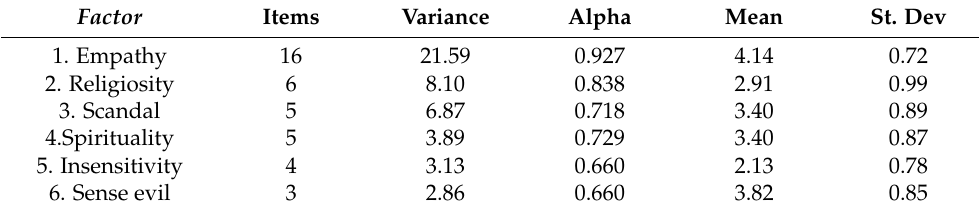
Table 2. Factor analysis, factors extracted with Varimax rotation and alpha over